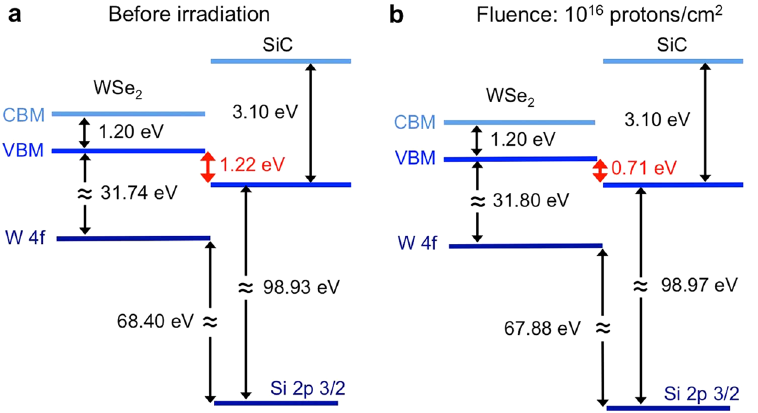
Figure 2. Valence band offset between WSe 2 and SiC in the WSe 2 /SiC heterostructure. The VBO was calculated using XPS spectra and was found to decrease after proton irradiation. It is assumed that the bandgap was not modified by the proton beam exposure (CBM: conduction band